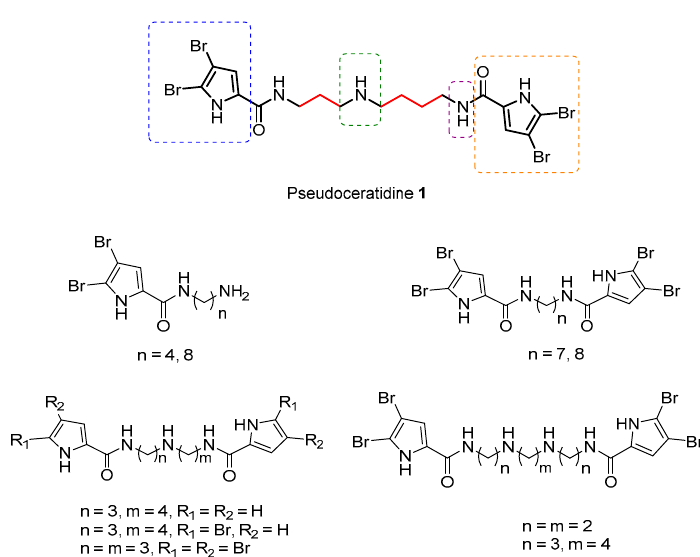
Figure 1. Molecular structure of pseudoceratidine 1 and previous analogues for which that antibacterial activity has been investigated. On psuedoceratidine 1 , the features investigated in this study are indicated by colour; the type and number of halogenation on the pyrrolic ring (blue), the length and symmetry of polyamine chain (red); the number of secondary amine groups—none, one or two (green)—the presence of a second pyrrolic unit (orange) and, if no pyrrolic unit, an alternative functionality (purple).